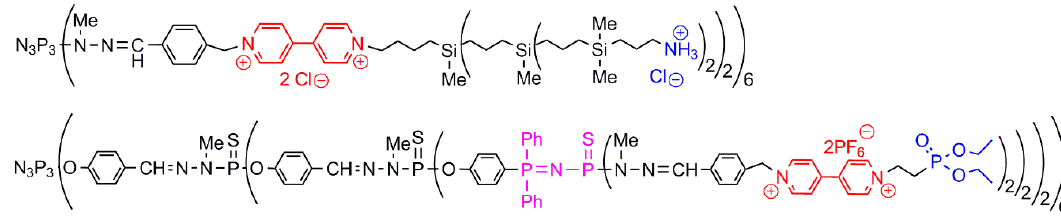
Figure 12. Examples of “onion peel” phosphorus dendrimers incorporating viologen units.